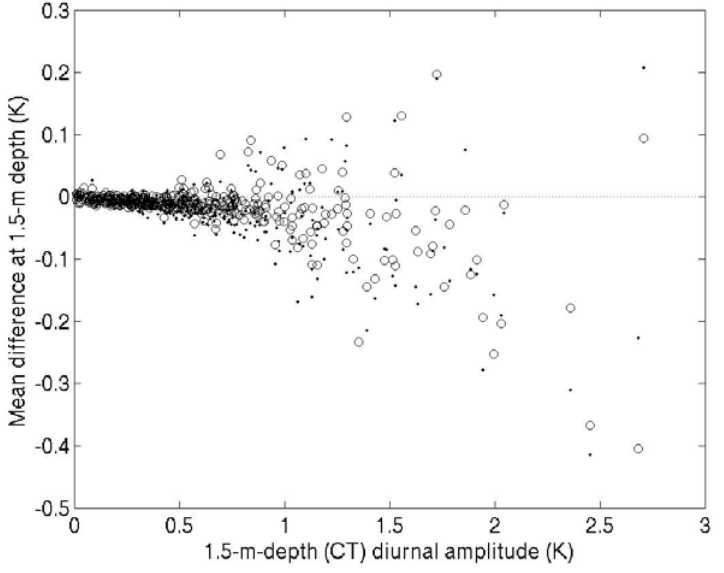
Figure 7. Temperature differences at 1.5 m between the right-side thermometer and the CT sensor (dot) and between the left-side thermometer and the CT sensor (circle) as a function of the diurnal amplitude of the CT temperature. The temperature differences were averaged between 1100 and 1500 LT. For the right-side thermometer, temperatures at 10-min intervals were calculated by linear interpolation. The temperatures measured by the left-side thermometer were re-sampled at 10-min